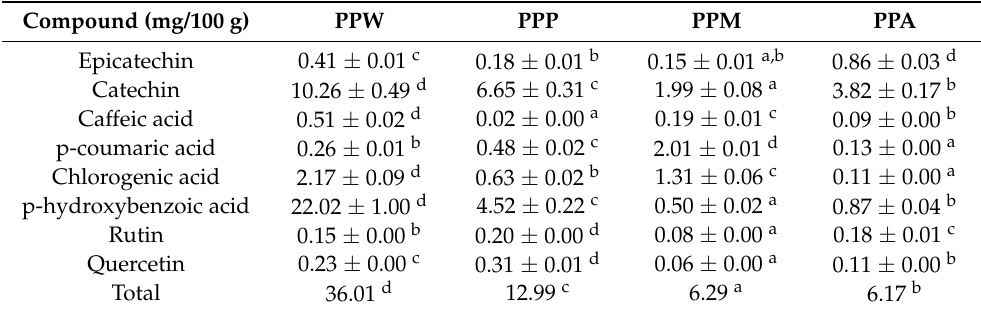
Table 1. Phenolics content in four peach encapsulates before digestion identified and quantified by HPLC. Compound (mg/100